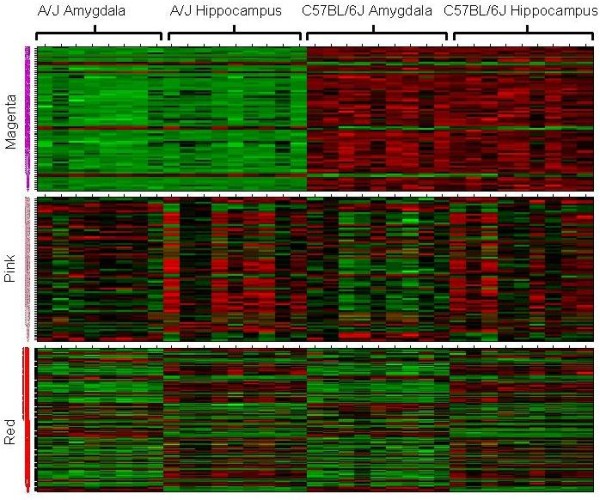
Gene expression heat map for significant modules. The rows correspond to genes and the columns to samples, with samples groups indicated at the top. Genes colored green are under-expressed, while red indicates over-expression. Expression in the Magenta module (top panel) is lower in A/J compared to C57BL/6J for almost all probes. Both up- and down-regulated probes compose the Pink (middle panel) and Red (bottom panel) modules when comparing amygdala and hippocampus.